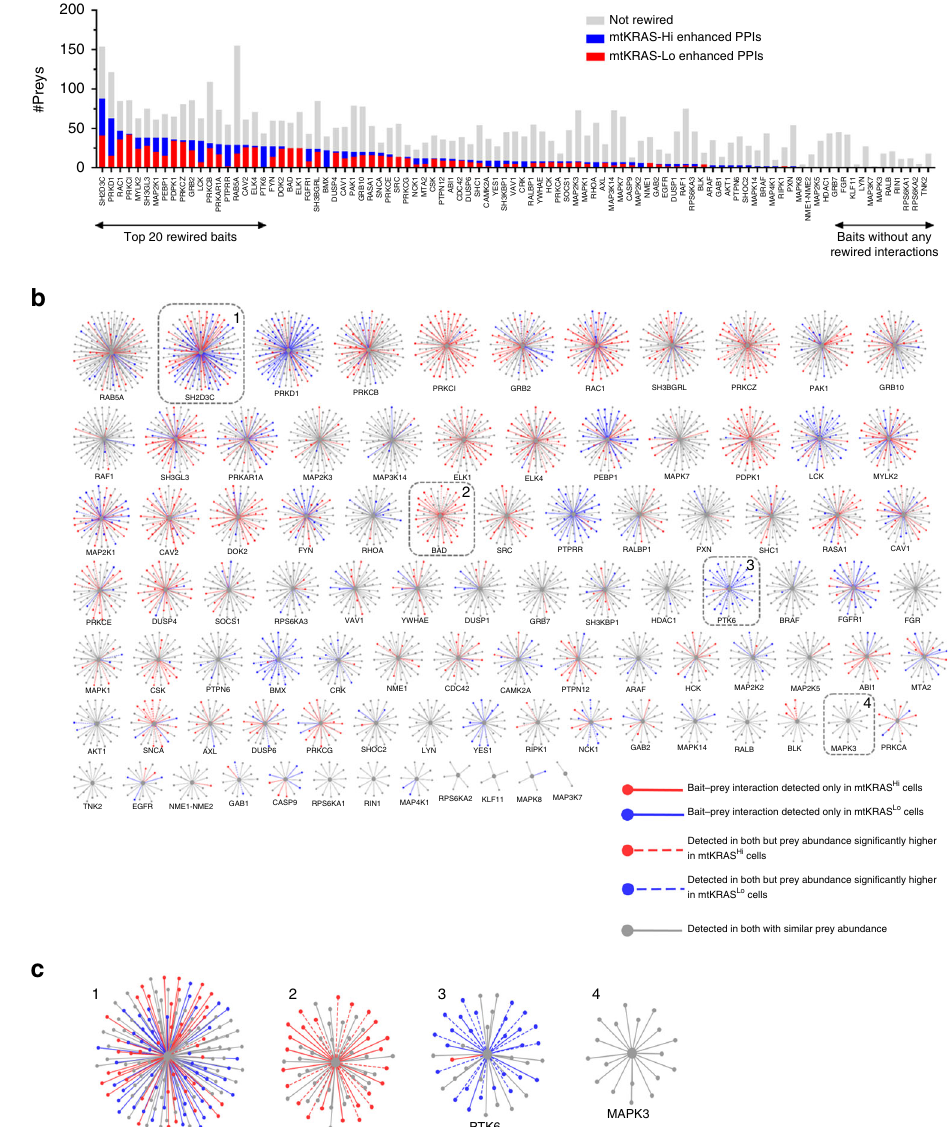
Fig. 2 The EGFRNet mtKRAS-Hi and EGFRNet mtKRAS-Lo PPINs are rewired. a The number of preys identi fi ed for each bait-prey AP-MS complex. Red, rewired preys enhanced in mtKRAS Hi cells; blue, rewired prey proteins enhanced in mtKRAS Lo cells. AP-MS complexes are named based on the bait protein and are shown on the x -axis. b Network spoke model view of rewired interactions. Bait – prey interactions identi fi ed in both networks with similar prey abundance are shown in gray. Bait – prey interactions that were identi fi ed only in EGFRNet mtKRAS-Hi or EGFRNet mtKRAS-Lo are shown as solid red or blue edges, respectively. Bait – prey interactions that were detected in both networks but where prey abundance was signi fi cantly higher in EGFRNet mtKRAS-Hi or EGFRNet mtKRAS-Lo are shown as dotted red or blue edges, respectively. Visit primesdb.eu to explore the complexes in more detail/with greater resolution. c Zoom-in on four nodes that represent mixed, preferential or no rewiring. Source data are provided as a Source Data fi